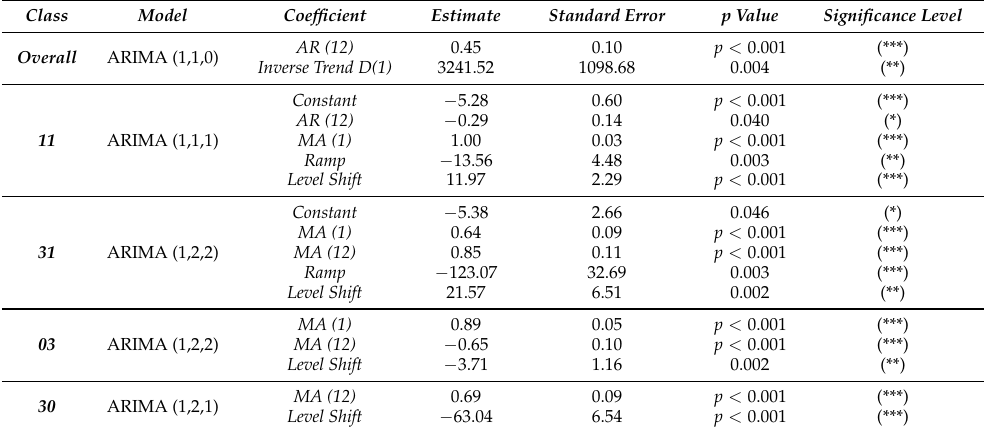
Table 4. ARIMAX models for evaluating the policy impact on opioid drugs for classes with significant intervention